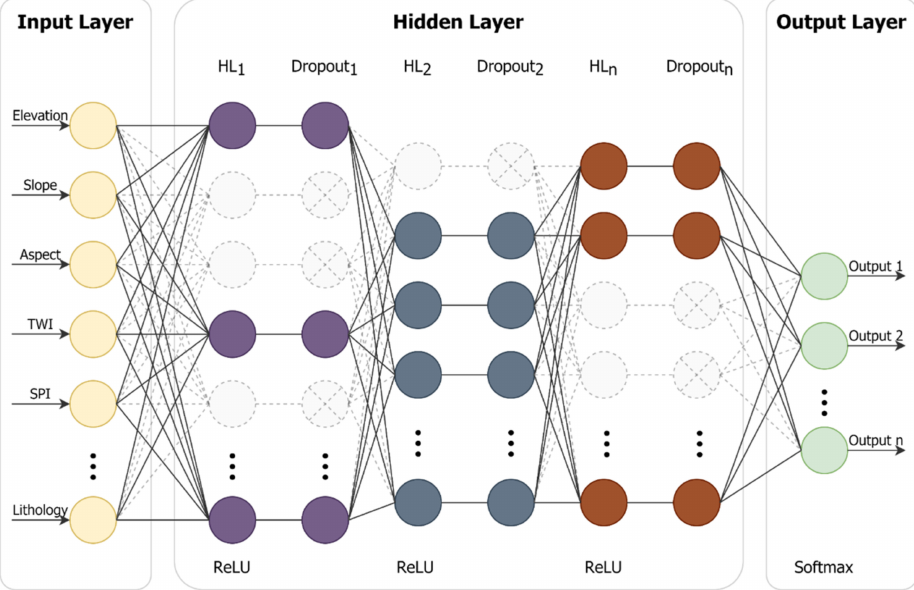
Figure 6. The MLP model